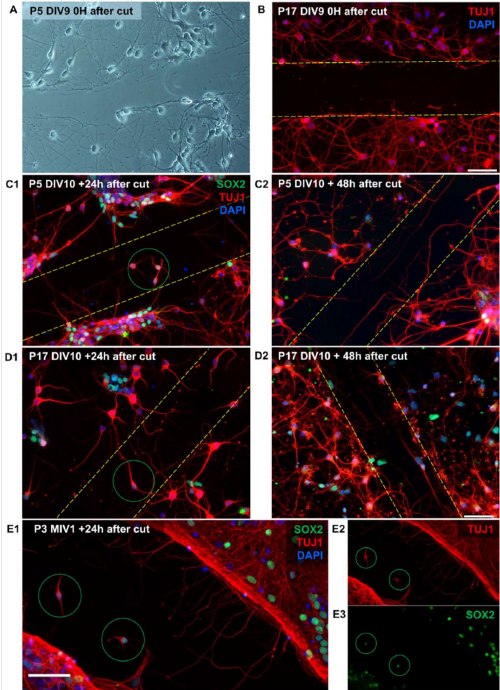
Figure 5. Cortical neuronal regeneration after injury in vitro. ( A , B ) Representative images of primary neuronal cultures immediately after a scratch. DIV9 live neurons from the P5 opossum cortex were imaged with phase contrast ( A ) and DIV9 neurons from the P17 opossum cortex fixed and stained